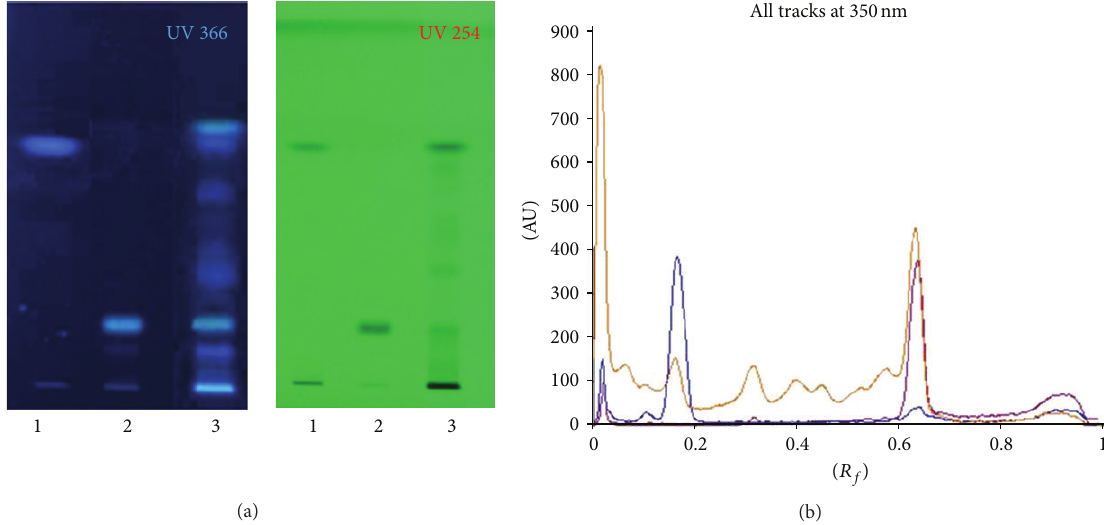
Figure 1: HPTLC fingerprint profile and densitometric scanning profile showing the separation of psoralen (1) and heraclenol (2) in methanolic extract of H. candicans fruits (3).